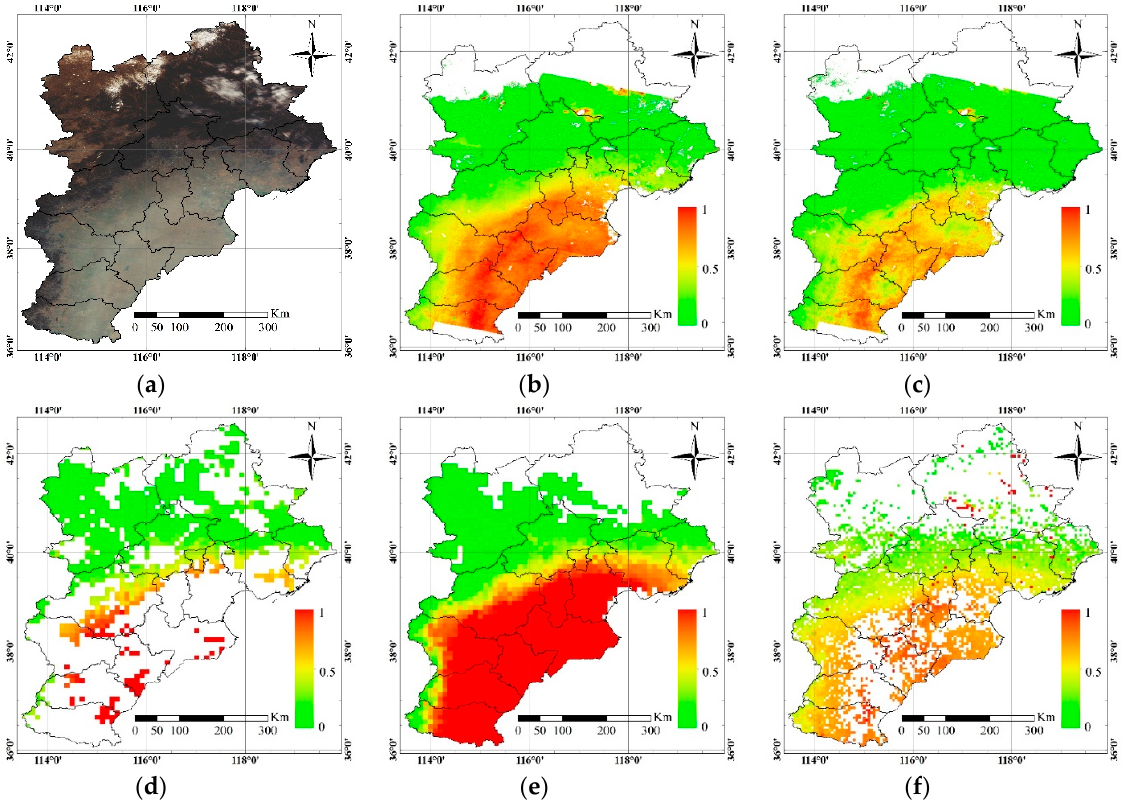
Figure 10. AOD spatial distribution on 1 January 2018. ( a ) Terra/MODIS true color image, ( b ) GF ‐ 1/WFV AOD_WORT, ( c ) GF ‐ 1/WFV AOD_WMRT, ( d ) Terra/MODIS AOD_MODT, ( e ) Terra/MODIS AOD_MODB, and ( f ) Himawari ‐ 8/AHI AOD_AHI.